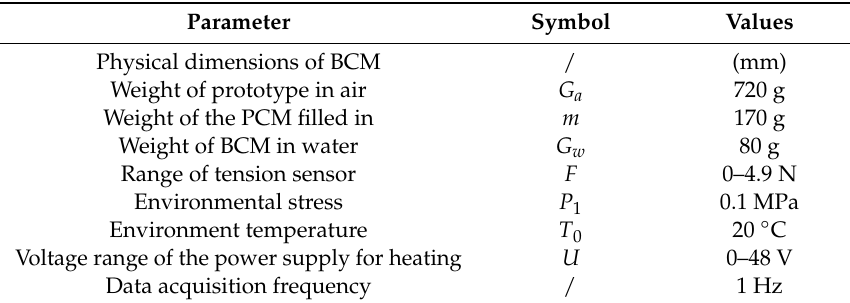
Table 1. Parameters of the test system.